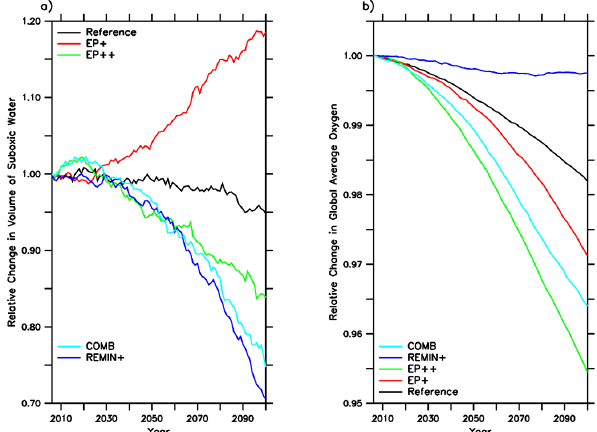
Figure 10. (a) The ratio of the simulated change in the volume of suboxic water to the simulated present-day (2006) value. (b) The ratio of the simulated change in the global ocean inventory of dis- solved oxygen to the simulated 2006